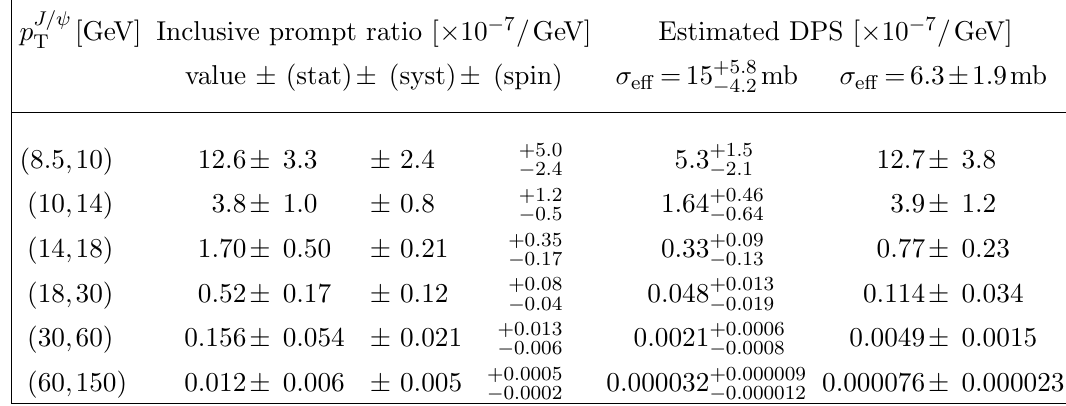
Table 9. The measured inclusive (SPS+DPS) cross-section ratio d R incl for j y j < 2 : 1. The estimated DPS contributions in each interval are listed for two possible values J= of (cid:27) e(cid:11)